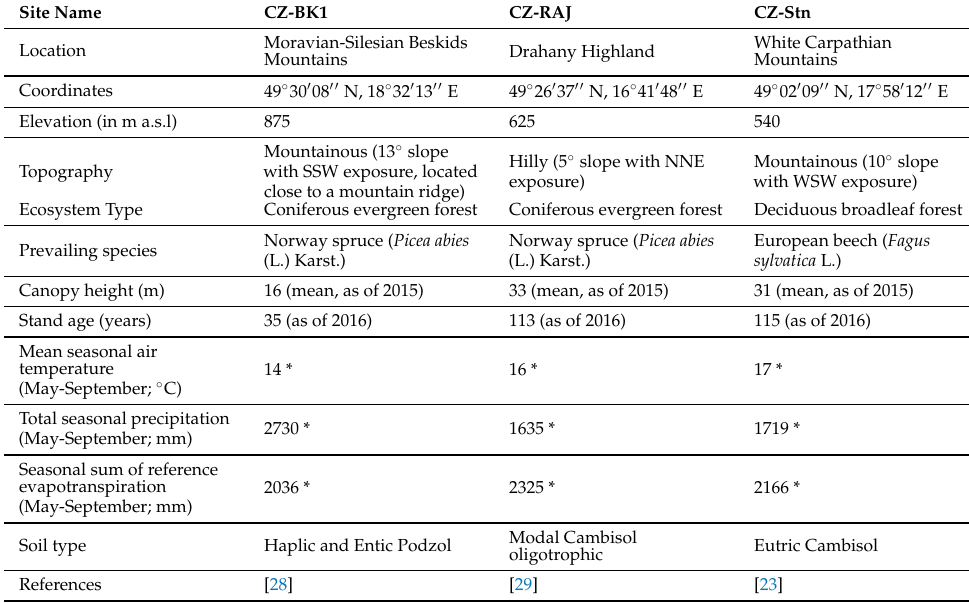
Table 1. Characteristics of the investigated